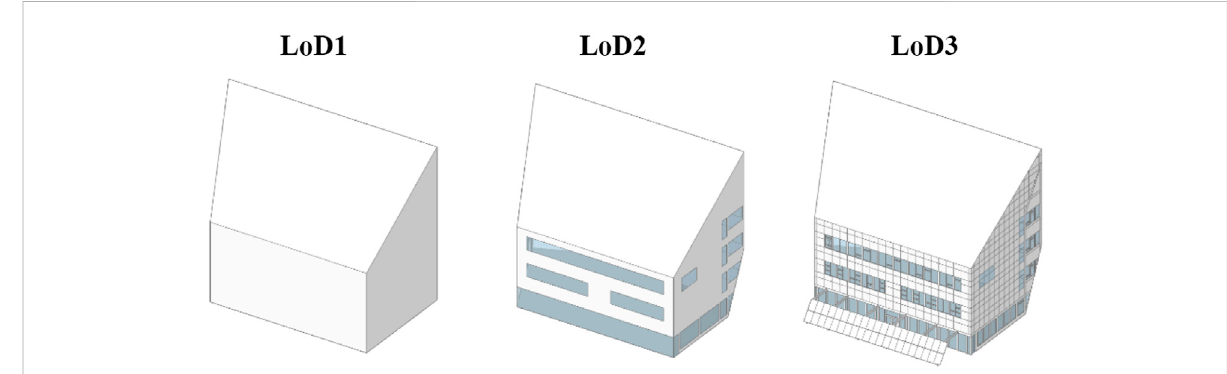
FIGURE 6 Different levels of detail associated with the 3D model of the ZEB Laboratory. The LoD3 is the one achieved in this study.